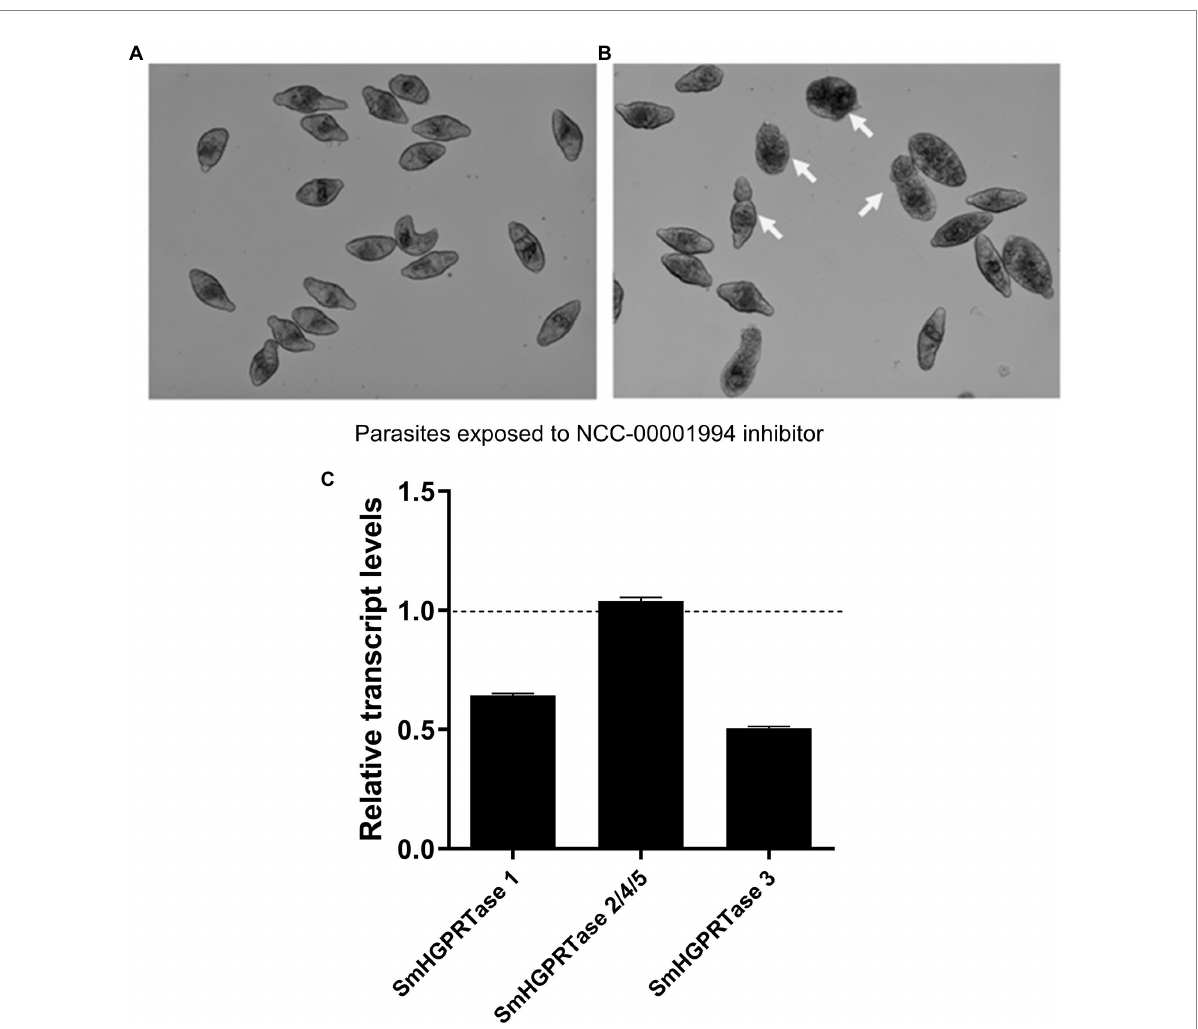
FIGURE 1 Experimental corroboration of Smp38 MAP kinase pathway in the regulation of the expression of SmHGPRTase 1, 2/4/5, and 3 . Representative images of schistosomula from the control (A) and schistosomula exposed to Smp38 predicted inhibitor NCC-00001994. (B) Arrows point to morphological changes in the parasites. (C) Bars representing the SmHGPRTase 1, 2/4/5, 3 transcript levels in schistosomula exposed to Smp38 predicted inhibitor NCC-00001994. Data were normalized relative to the SmHGPRTases expression levels in parasites exposed to DMSO (dashed